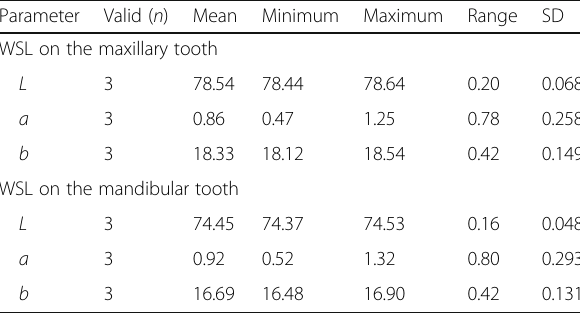
WSL white spot lesions, L lightness, a red-green axis, b yellow-blue